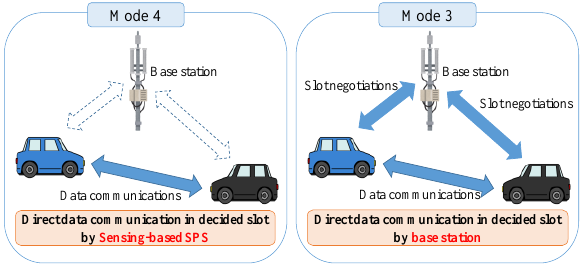
Figure 1. The characteristics of mode 4, as compared to mode 3.